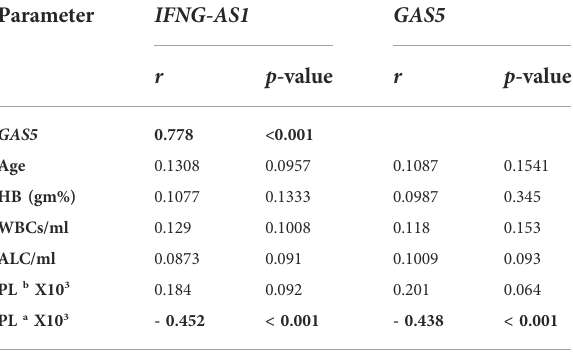
TABLE 4 Pearson correlation analysis of the expression of IFNG-AS1 and GAS5 with age and blood smear parameters.